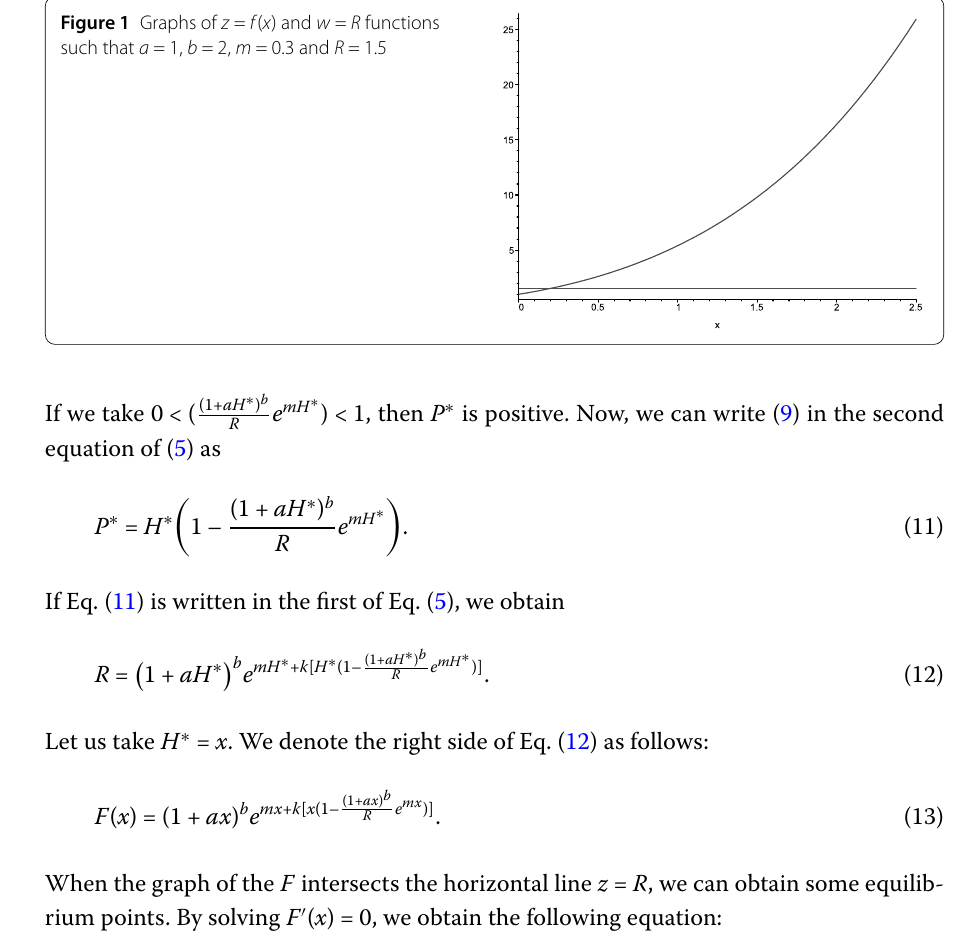
Figure 1 Graphs of z = f ( x ) and w = R functions such that a = 1, b = 2, m = 0.3 and R =